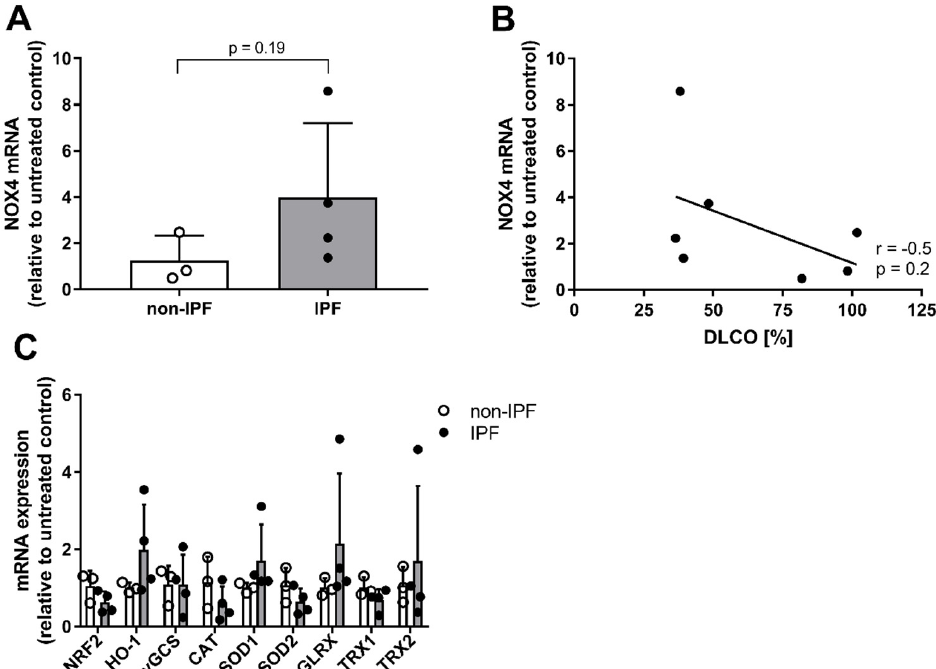
Figure 3. HBE cells derived from IPF patients have different gene expression levels of NOX4 and endogenous antioxidants. ( A ) NOX4 expression levels in HBE cells from IPF patients ( n = 4) and controls ( n = 3). Data are presented as mean ± SD. ( B ) Correlation of NOX4 expression with DLCO (%). ( C ) Antioxidant gene expression in HBE cells from IPF patients ( n = 4) and controls ( n = 3). Data are presented as mean ± SD. Gene expression is expressed relative to non-IPF controls.